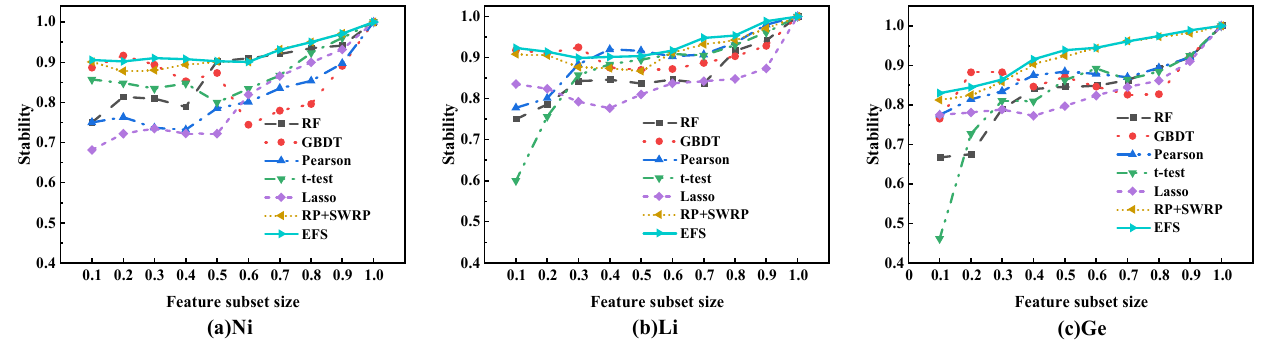
Figure 9. The relationship between stability and feature subset size.